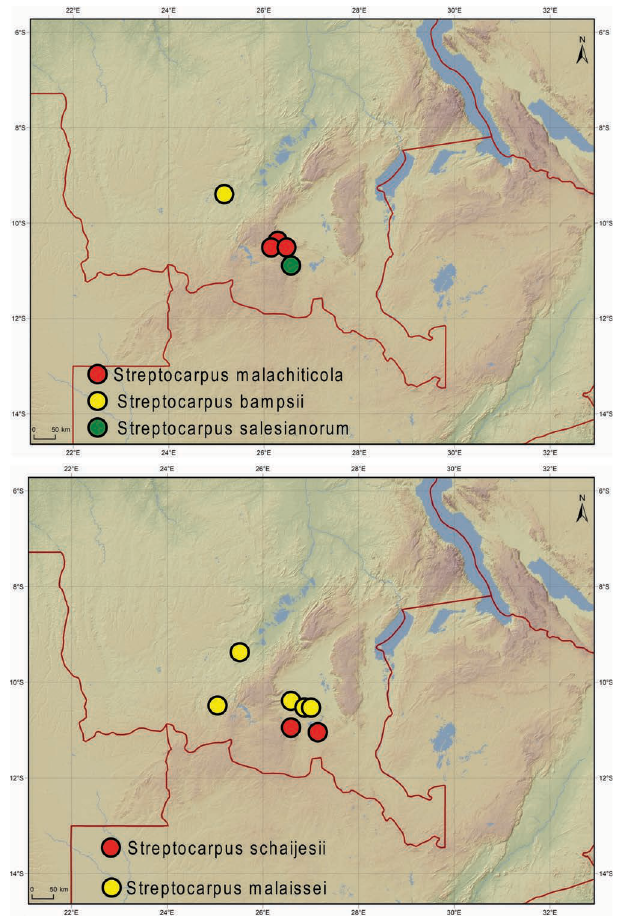
Figure 9 – A . Distribution map of Streptocarpus malachiticola , S. bampsii , and S. salesianorum . B . Distribution map of S. schaijesii and S. malaissei . Map created using ArcMap 10.8